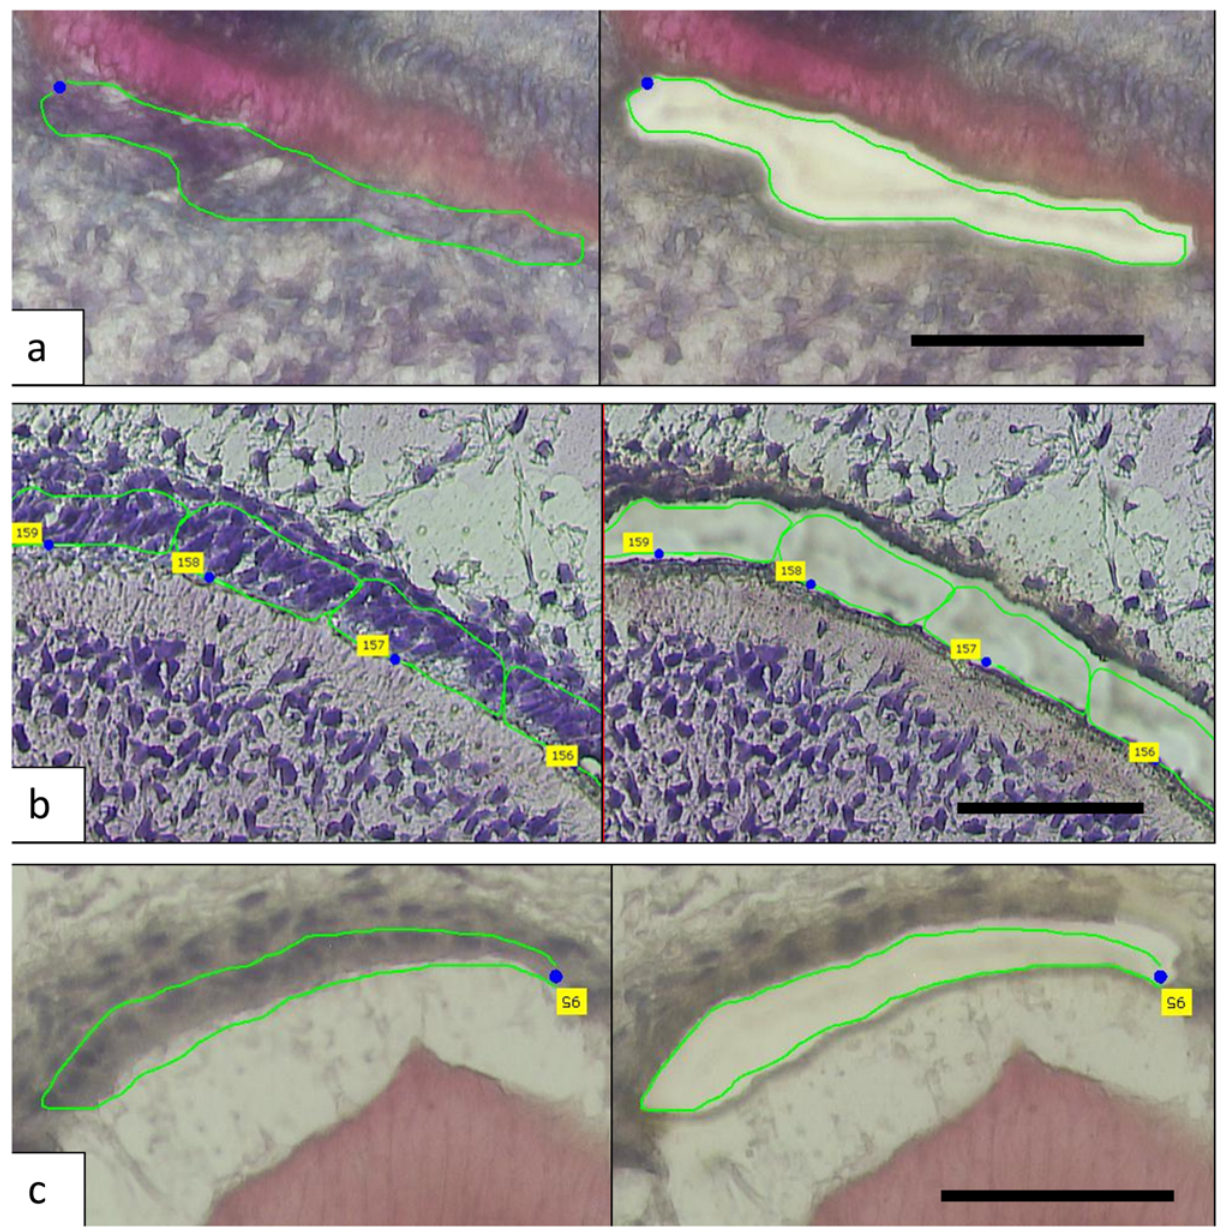
Fig 1. The micrographs show the laser capture of a — odontoblasts, b — pre-secretory ameloblasts and c — secretory ameloblasts. The left panel shows pre-capture and area to be captured while the right panel shows post-capture and the removal of target cells. Scale bar: 50 μ